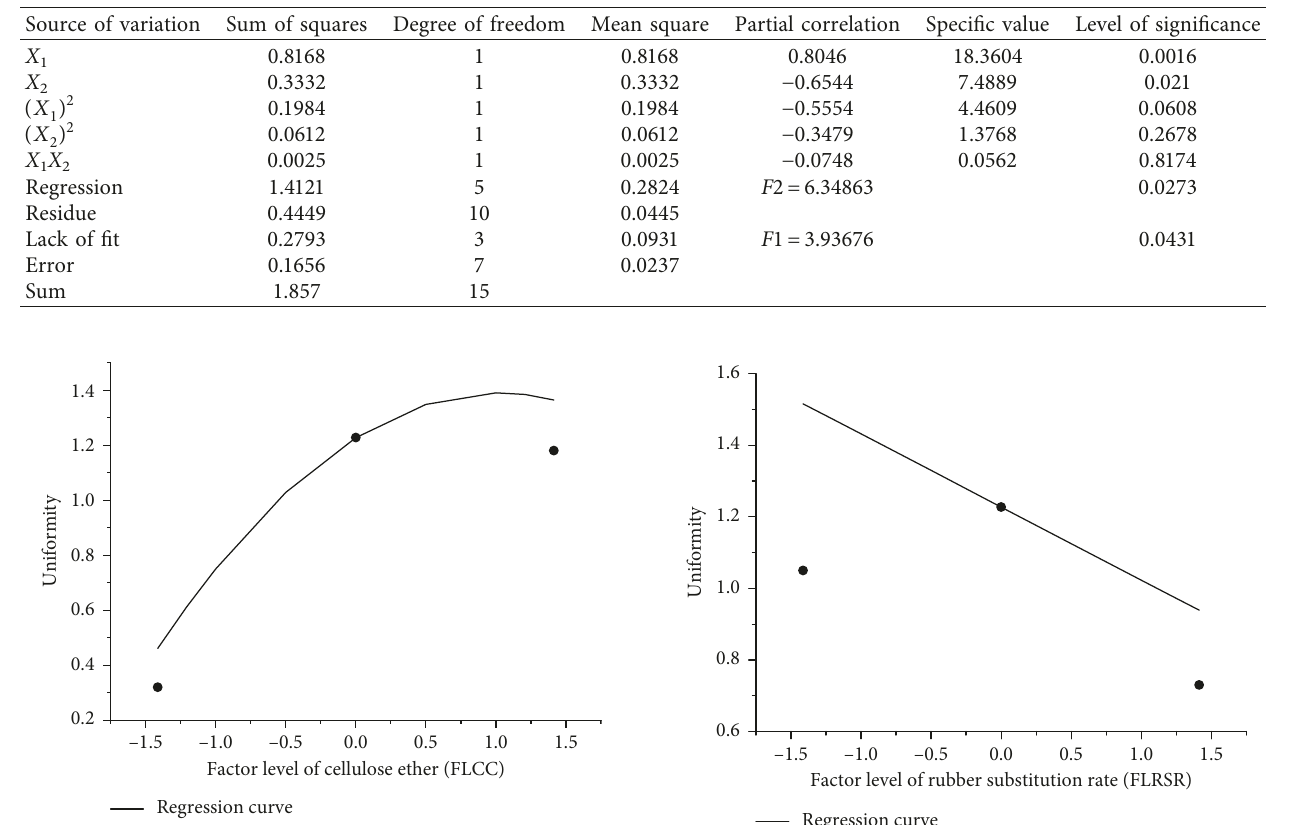
Table 8: Variance analysis of uniformity of mortar.